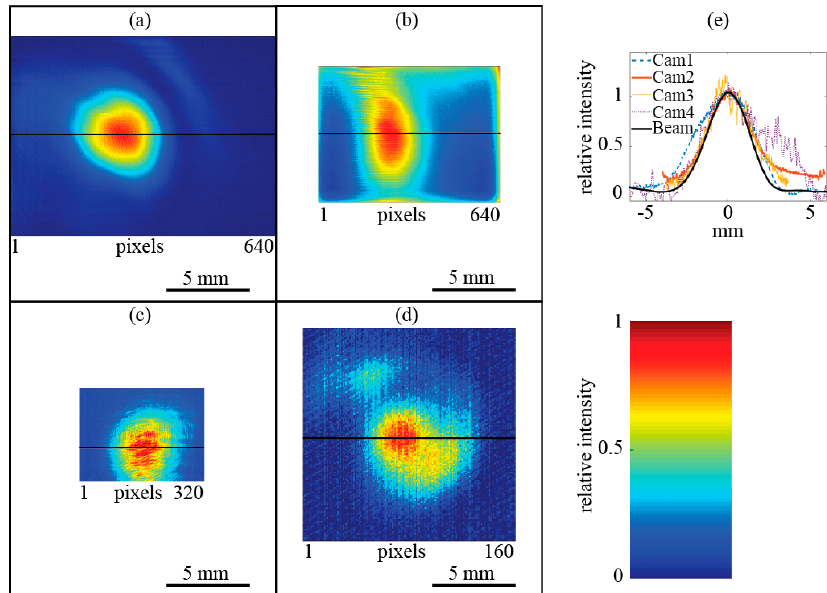
Figure 3. Beam profile at a wavelength of λ = 118.8 μ m measured with the four cameras. ( a ) Cam1; ( b ) Cam2; ( c ) Cam3; ( d ) Cam4; ( e ) horizontal cross-section through the measured laser spots and the beam profile (black line).